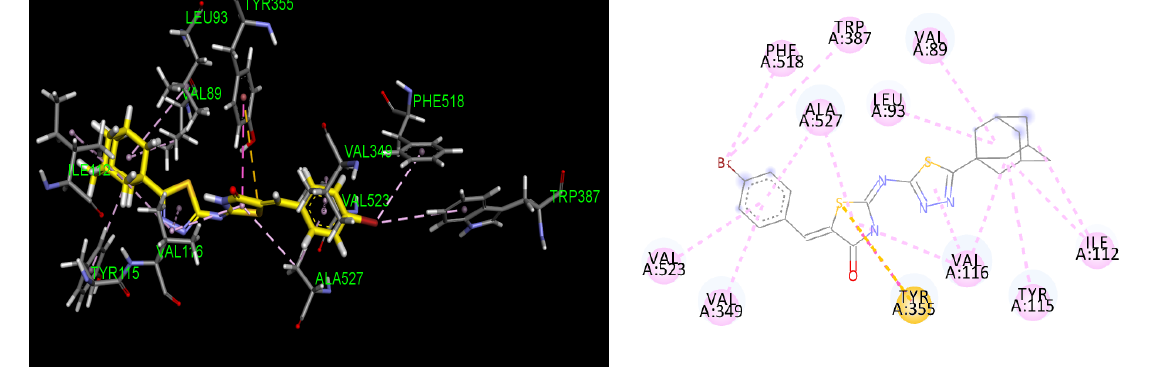
Figure 5. Three- and two-dimensional representations of the binding mode of compound 3 in COX-2 active site (PDB 3LN1 and 6BL3). H-bond, halogen, pi–pi, pi–alkyl and pi-cation interactions are represented as dotted lines in green, blue, violet, grey and orange, respectively.